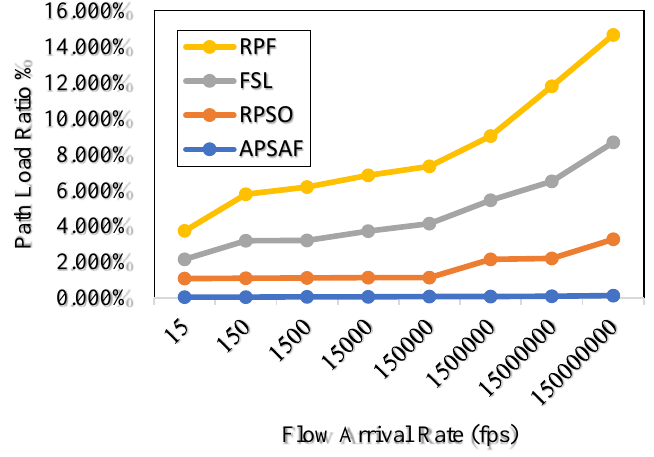
Figure 8. Packet Load Ratio.